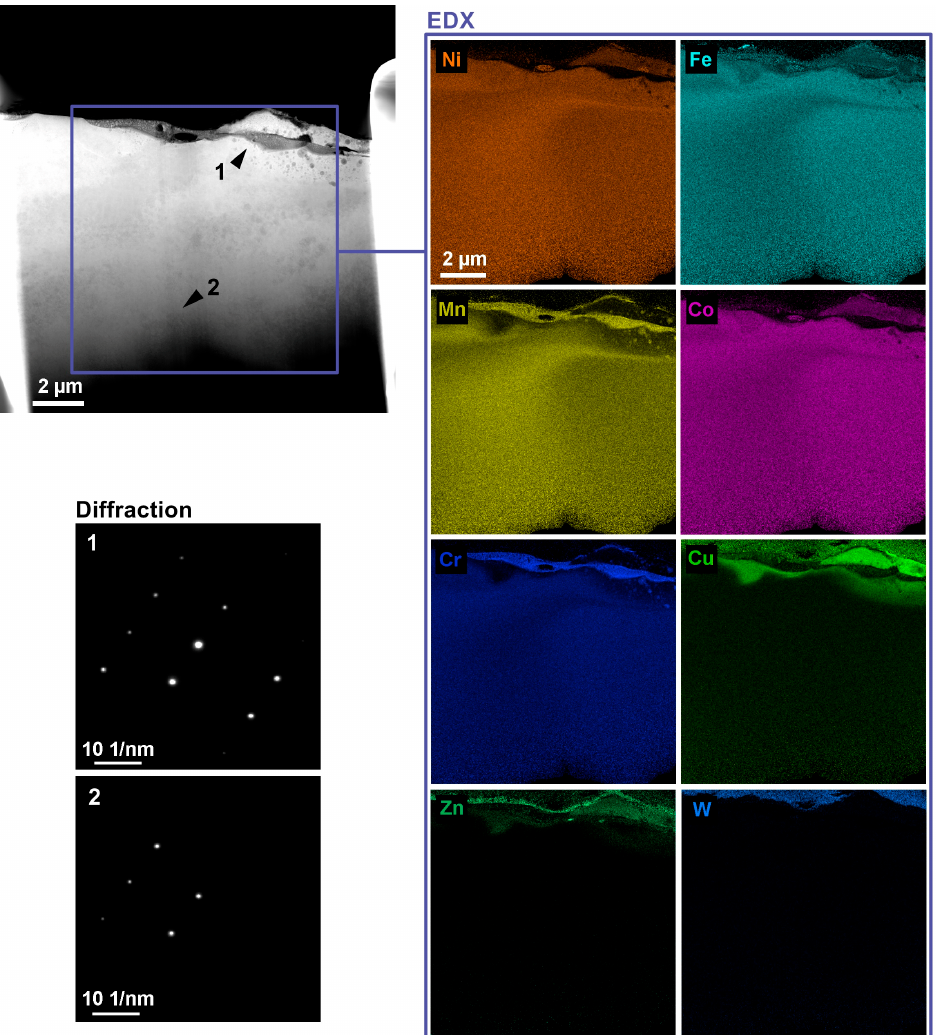
Figure 9. Transmission electron microscope (TEM) lamella made of 1Fe alloy, including maps of distribution of individual elements in various details and di ff raction